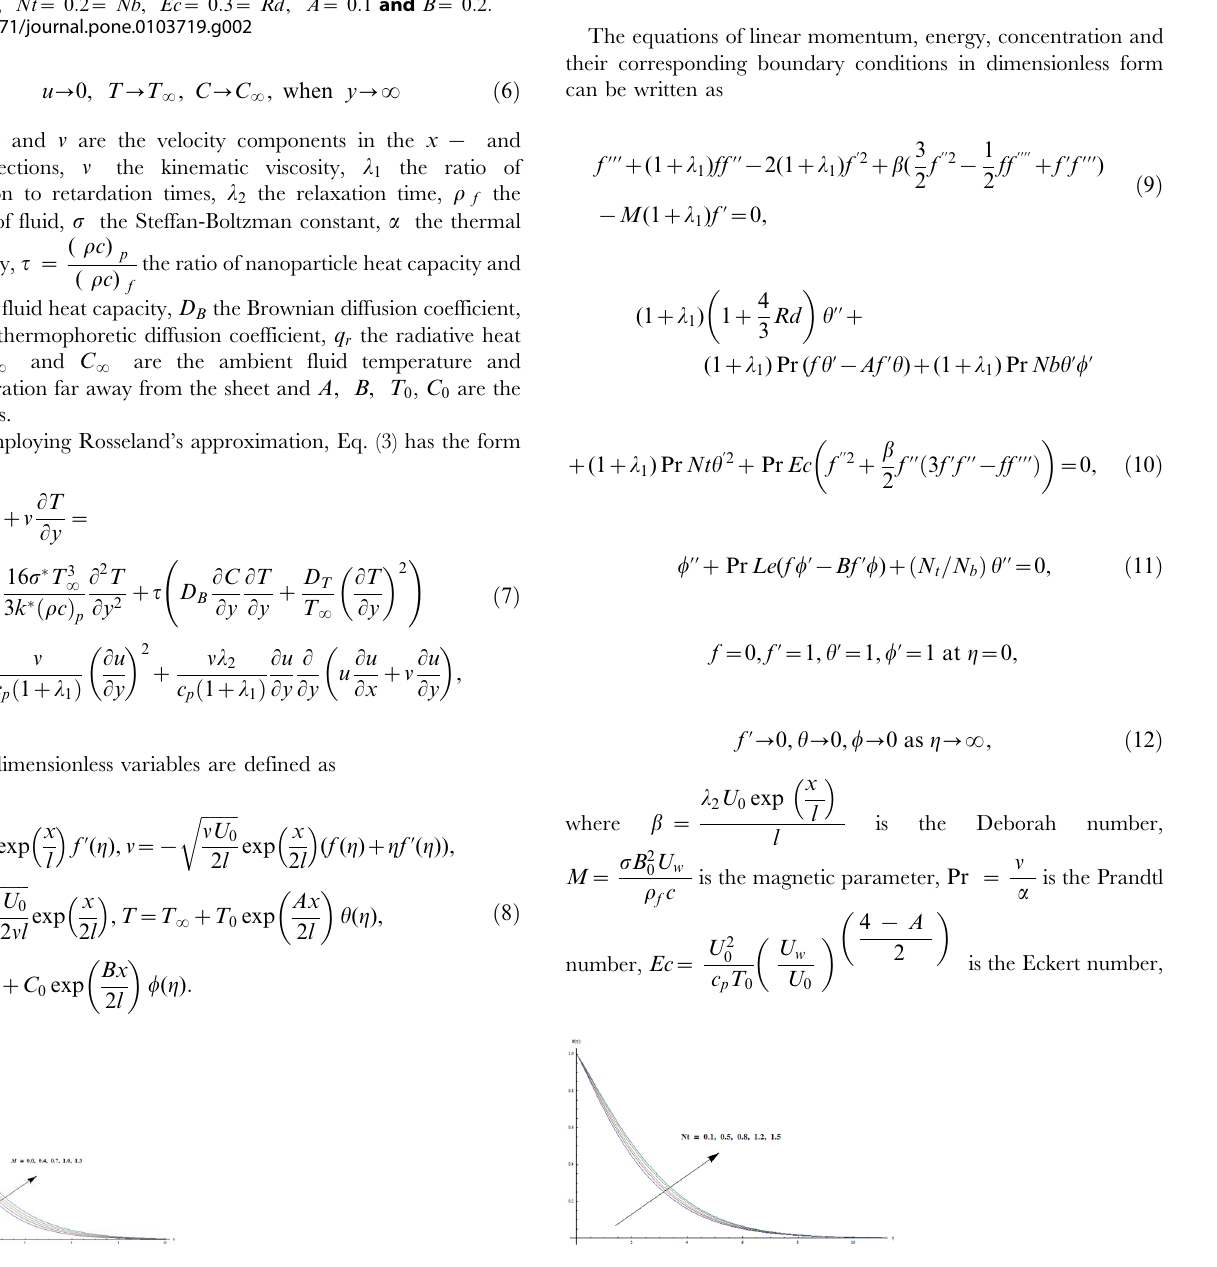
Figure 2. Variation in dimensionless temperature h ( g ) vs g for different values of l 1 when b ~ 0 : 2, M ~ 0 : 5, Pr ~ 0 : 7,